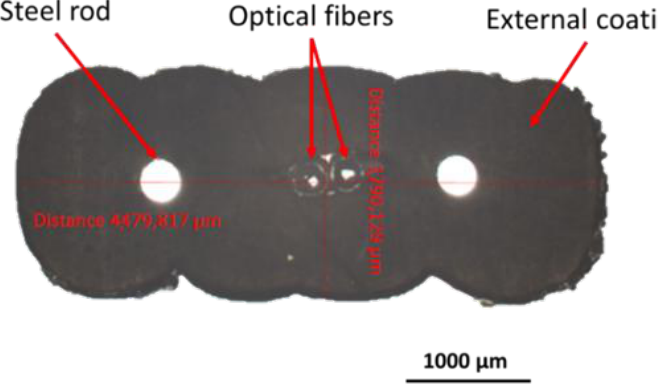
Figure 9. Cross-section of the DOFS cable, as observed by optical microscopy.